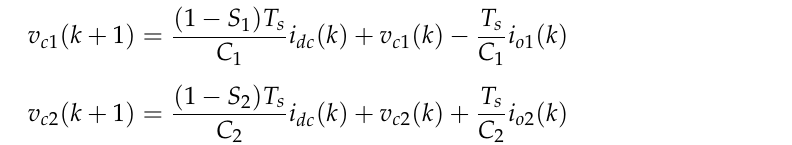
Figure 9. The cost function flow chart of the boost-TL converter model prediction algorithm.